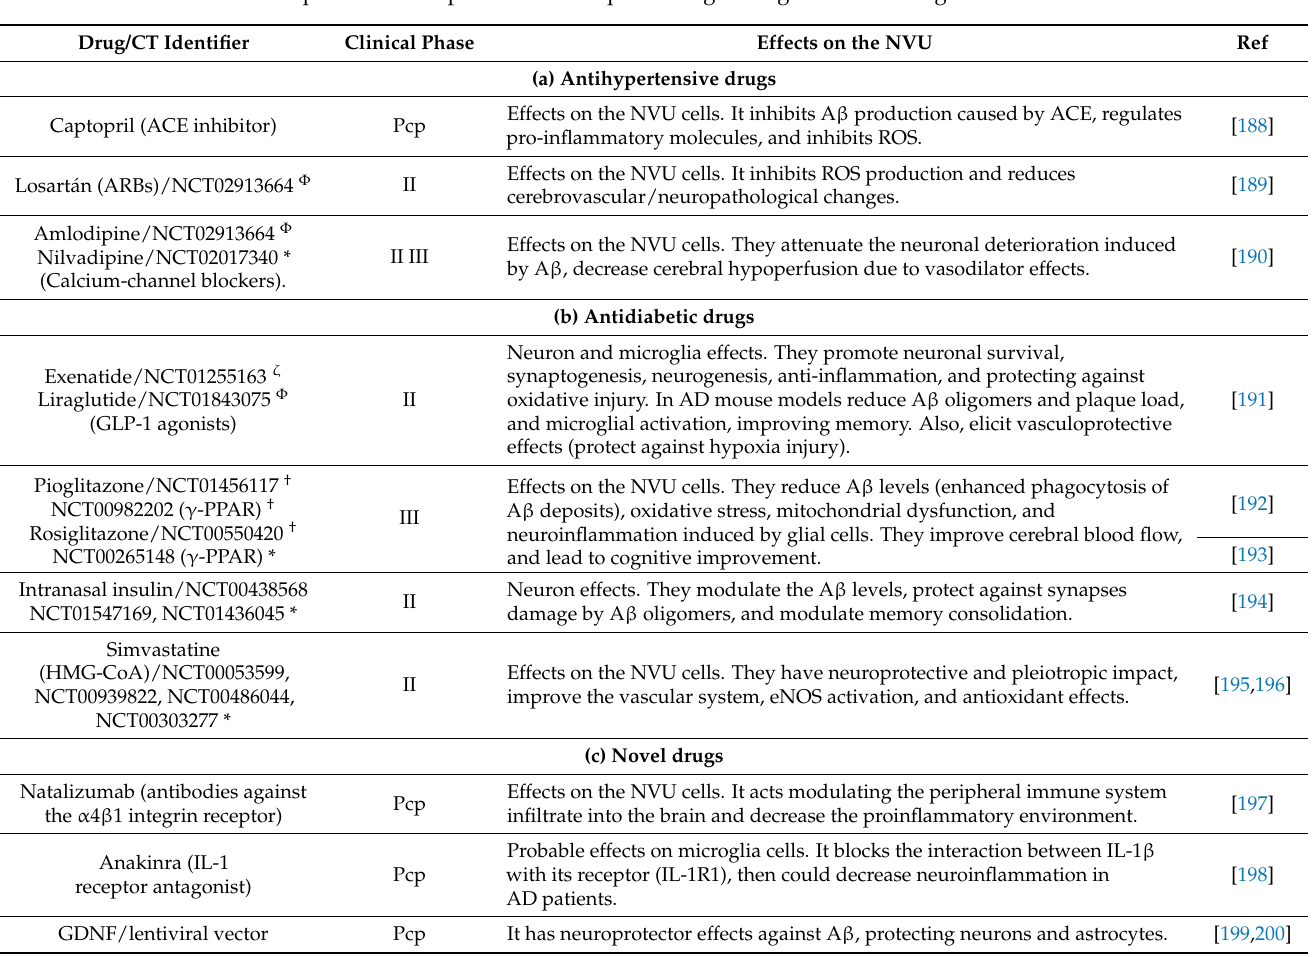
Table 3. The effects of potential therapies focused on preventing damage to or restoring function of the NVU in AD. Drug/CT Identifier Clinical Phase Effects on the NVU